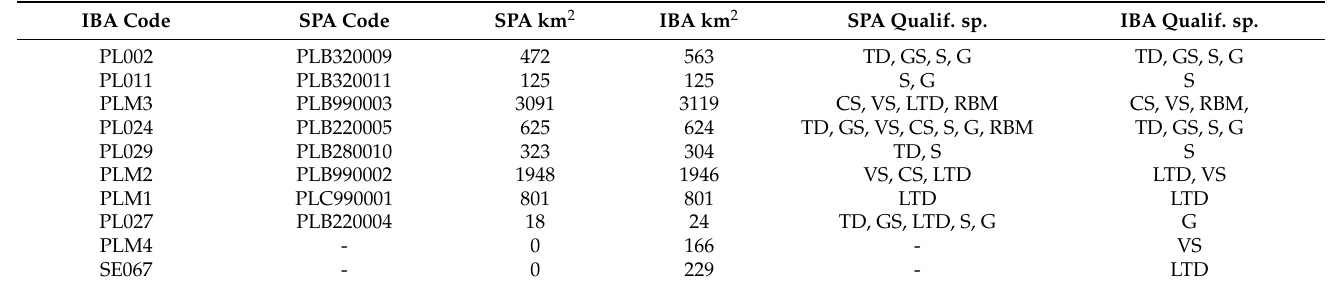
Table 3. Comparison of the size of areas and their qualifying bird species in areas designated by BirdLife International (IBA) and by the Polish government (Natura 2000 SPA). Species abbreviations: VS—Velvet Scoter, LTD—Long-tailed Duck, GS—Greater Scaup, CS—Common Scoter, S—Smew, G—Goosander, RBM—Red-breasted Merganser, TD—Tufted